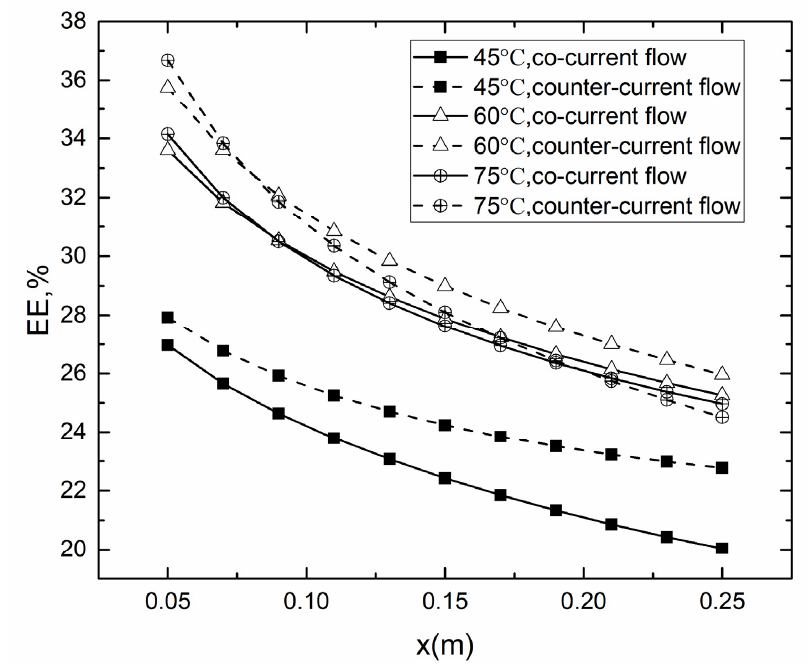
Figure 9. Evaporation efficiency (EE) for co- and counter-current operations in different T f . ( T p = 25 °C, v f , v p = 0.15 m/s, c f = 24.2 wt.%). v f , v p = 0.15 m / s, c f = 24.2